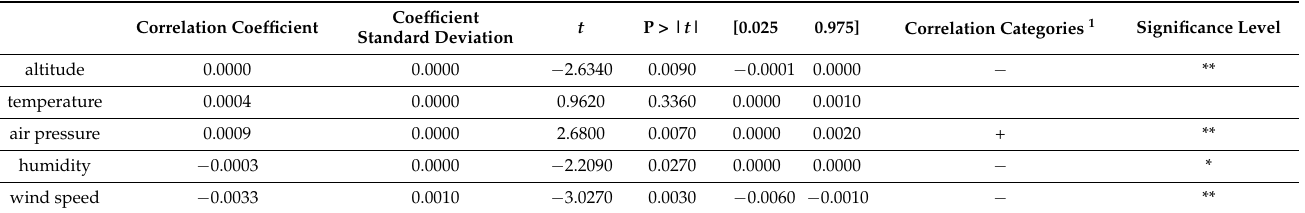
Table 2. The correlation performance of each feature when the dependent variable is average speed difference of Q2–Q3.